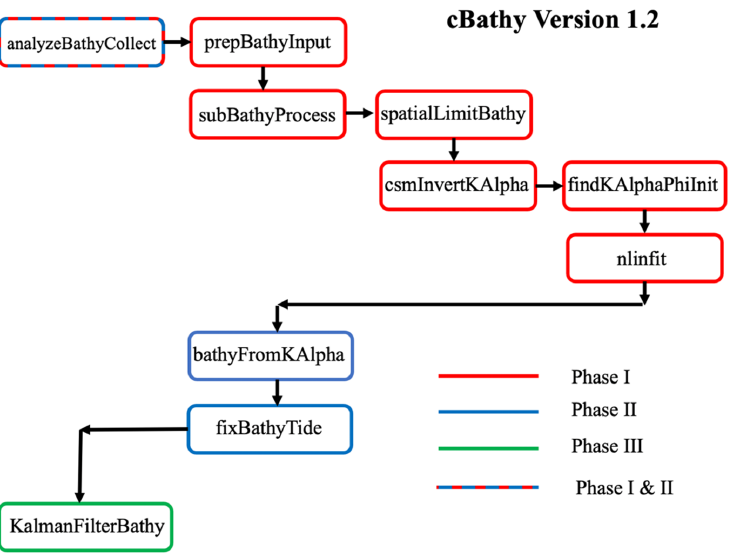
Figure 5. Organization of cBathy version 1.2 (and 1.0) showing the three phases of the algorithm by color.